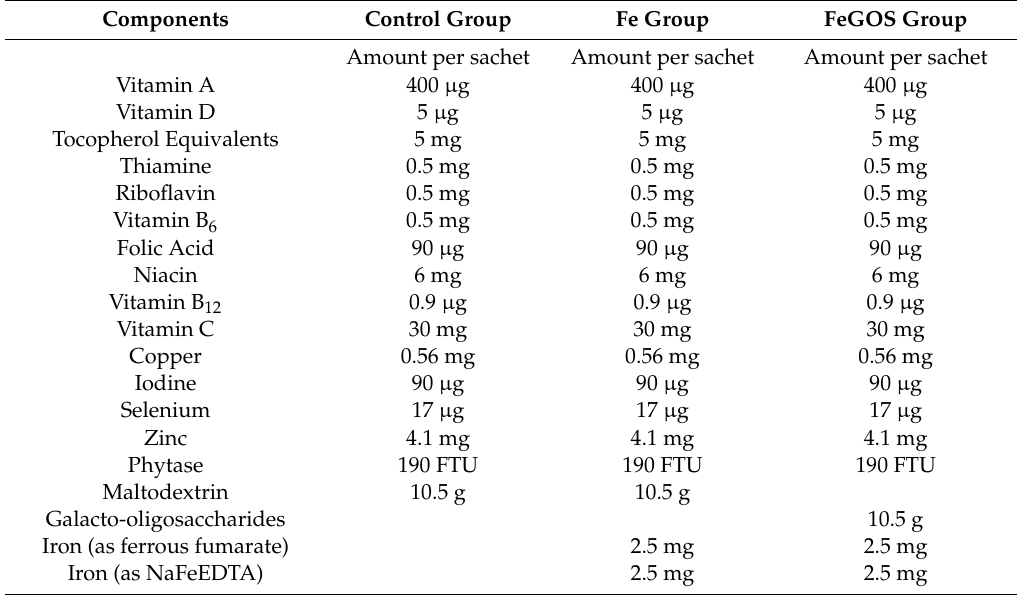
Table 1. Composition of the micronutrient powder formulations used in this